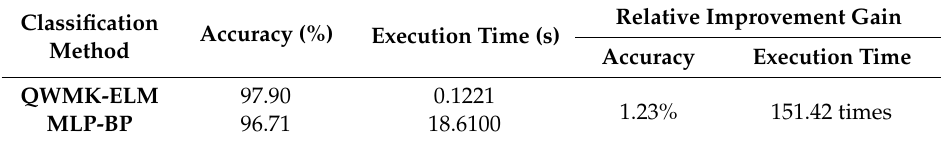
Table 8. Accuracy and execution time improvement gain with respect to the best competitor for Dataset I.